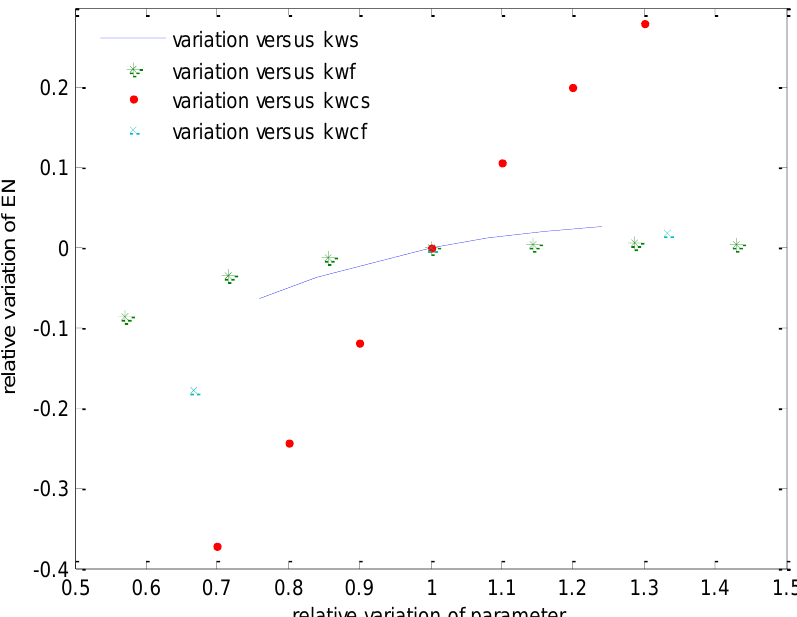
Fig. 6. The relative variation of E{ N }with respect to changes in the parameters: weighted procedure with w (1)= w (19)= w (22)=2